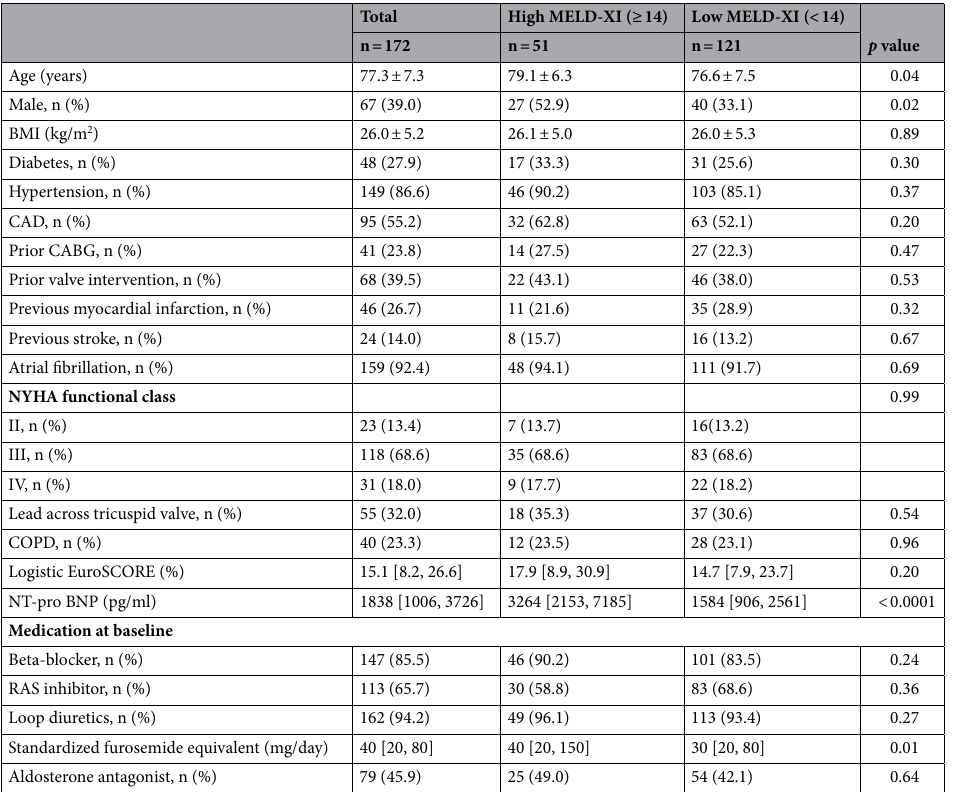
mass index, CAD coronary artery disease, CABG coronary artery bypass grafting, NYHA New York Heart Association, COPD chronic obstructive pulmonary disease, NT-proBNP N-terminal pro-B-type natriuretic peptide, EuroSCORE European System for Cardiac Operative Risk Evaluation, RAS renin angiotensin